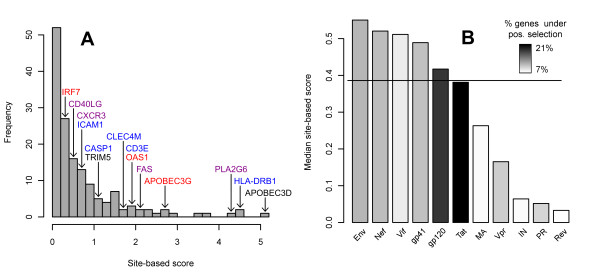
Distribution of the site-based score in the genes of four primate species. (A) Distribution of all gene scores. Positions of important host factors are indicated. Colors indicate the functional group to which the factors belong: blue - membrane-related proteins, red - innate immune response proteins, magenta - both, black - none of the groups. (B) Median values of site-based scores in the interaction grouping. Shown are groups of the size >2% of all interactions. Bar colors indicate the percentage of the genes under positive selection in each group as inferred by LRT (listed in Table 1). CA protein (not shown on the figure) has less that 1% interactions reported in the dataset showing a high median of 1.3.